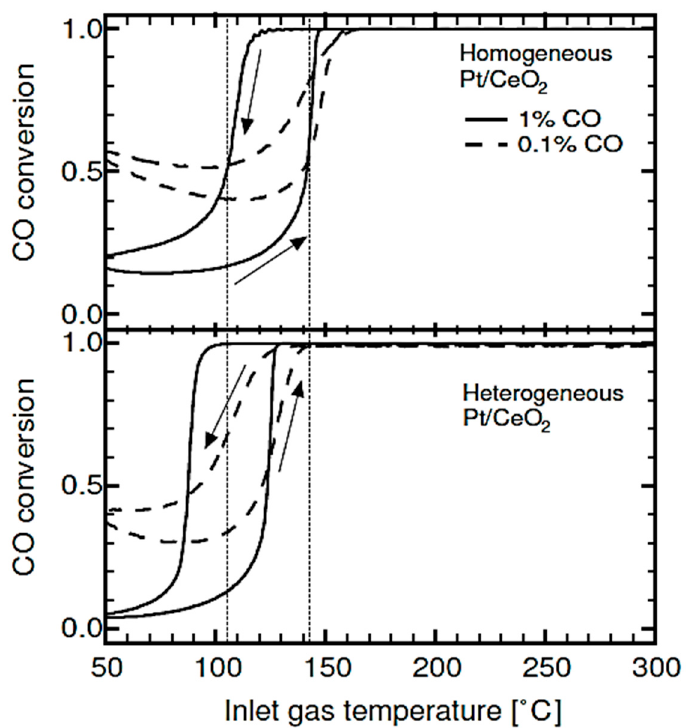
Figure 6. Temperature-programmed oxidation of 0.1 and 1% CO with 9% O 2 over homogeneous (top panel) and heterogeneous (bottom panel) Pt/CeO 2 monolith catalysts using heating/cooling rates of 5 ◦ C/min [5].